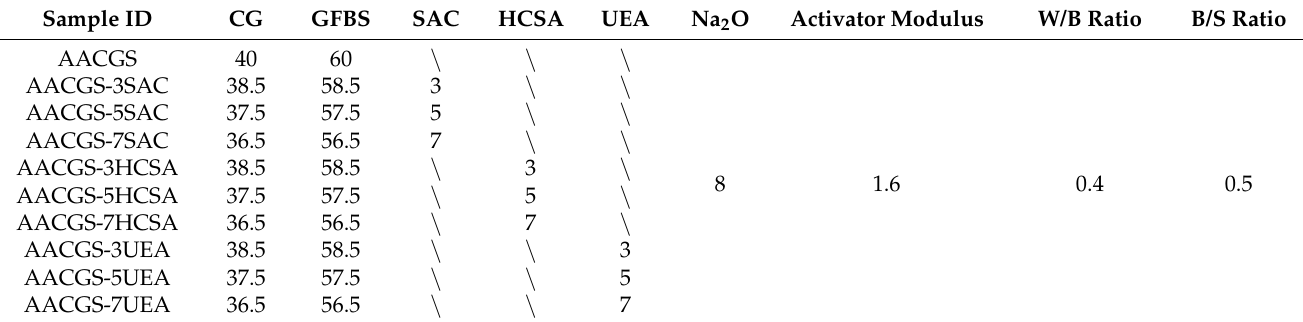
Table 2. Mix proportions